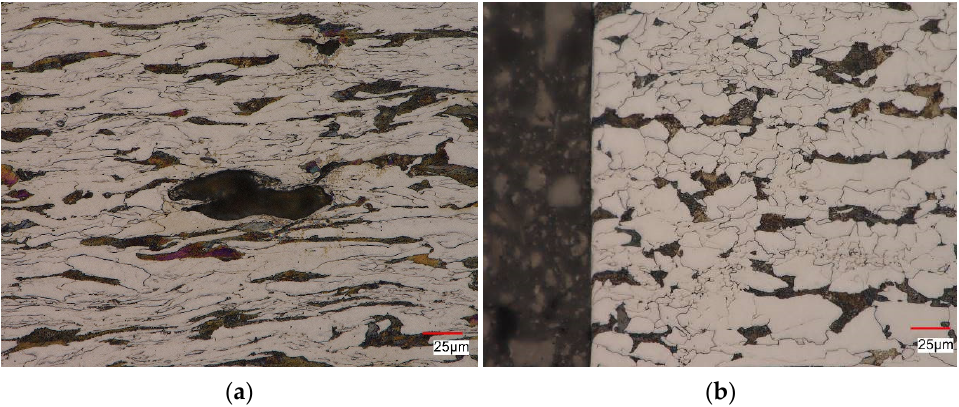
Figure 18. Structure of S420M steel: ( a ) after static tensile test, ( b ) after initial deformation equal to 10%.